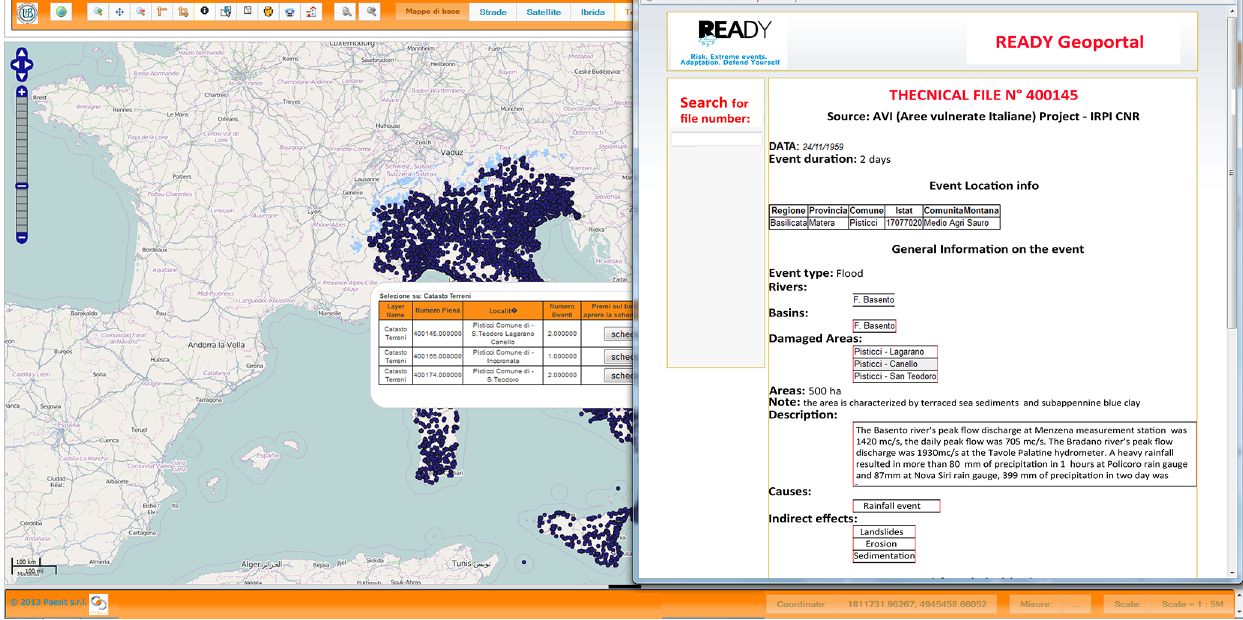
Figure 12. READY form for showing all the information of a selected historical